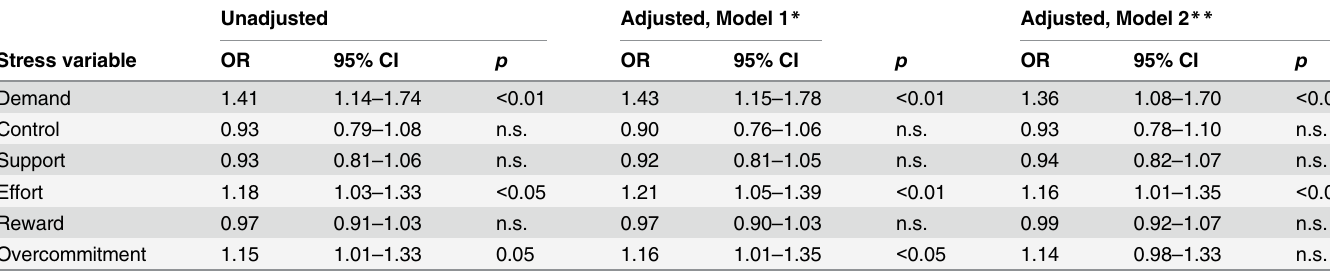
Table 4. Association of stress variables with incident cases of metabolic